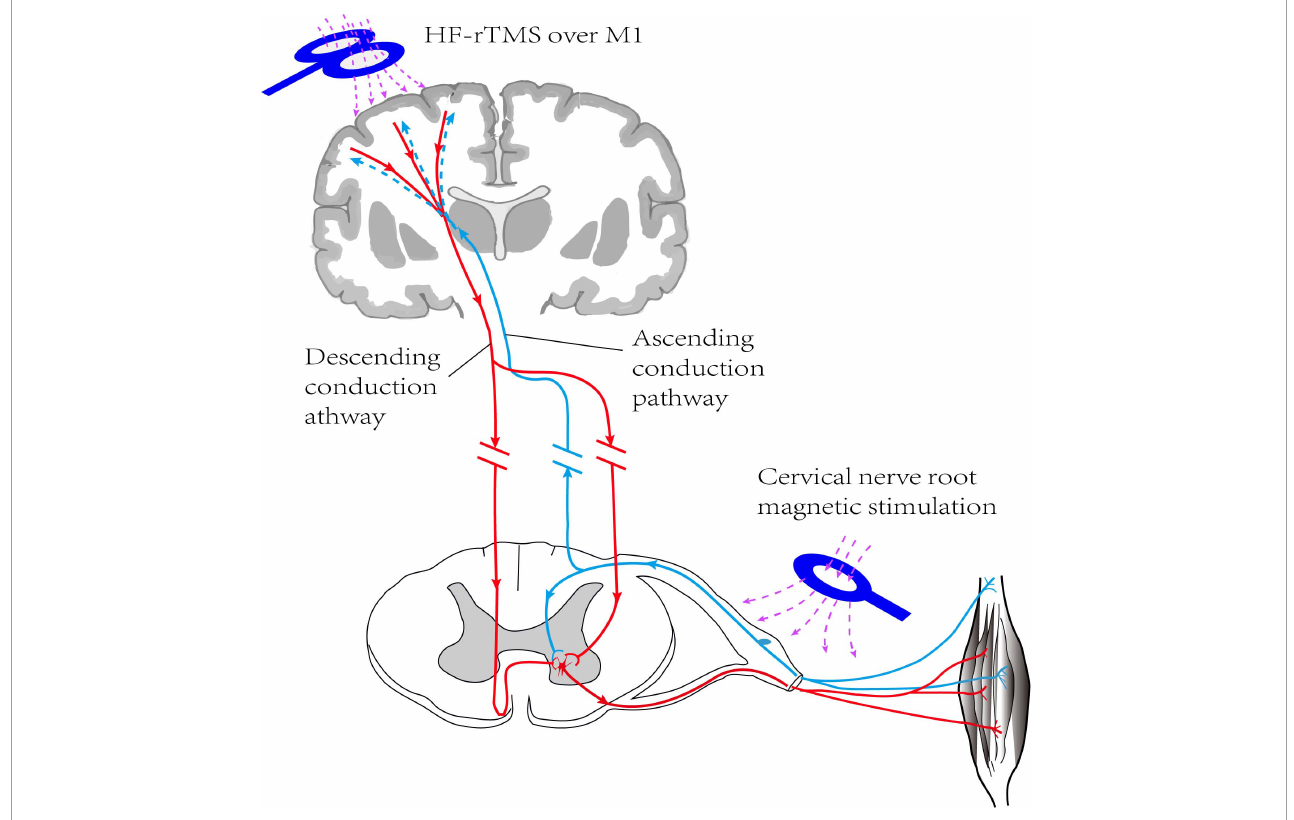
FIGURE2 Schematic diagram of HF rTMS over ipsilateral M1 combined with magnetic stimulation of cervical nerve root on hemiplegic side (non-simultaneous). HF-TMS, high frequency repetitive transcranial magnetic stimulation; M1, primary motor cortex.